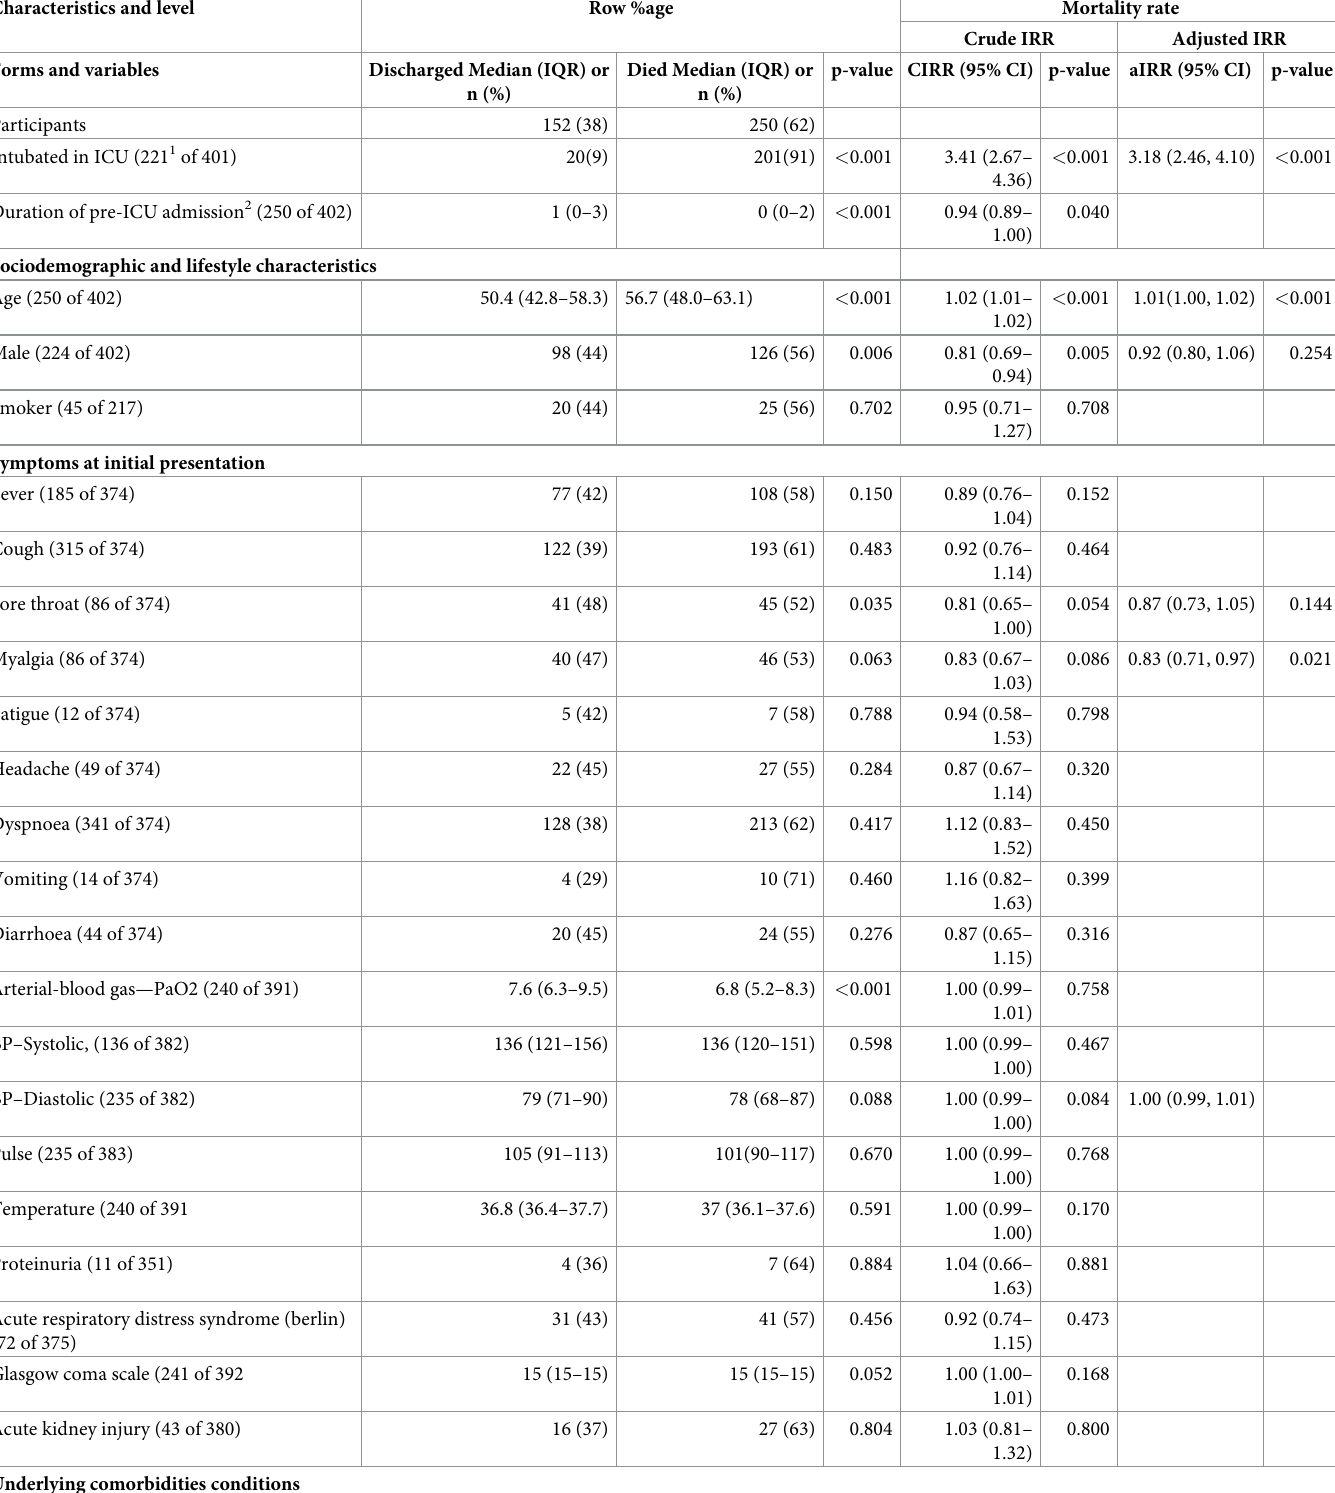
Table 2. Socio-demographic and clinical characteristics associated with mortality among COVID-19 patients admitted to ICU. Characteristics and